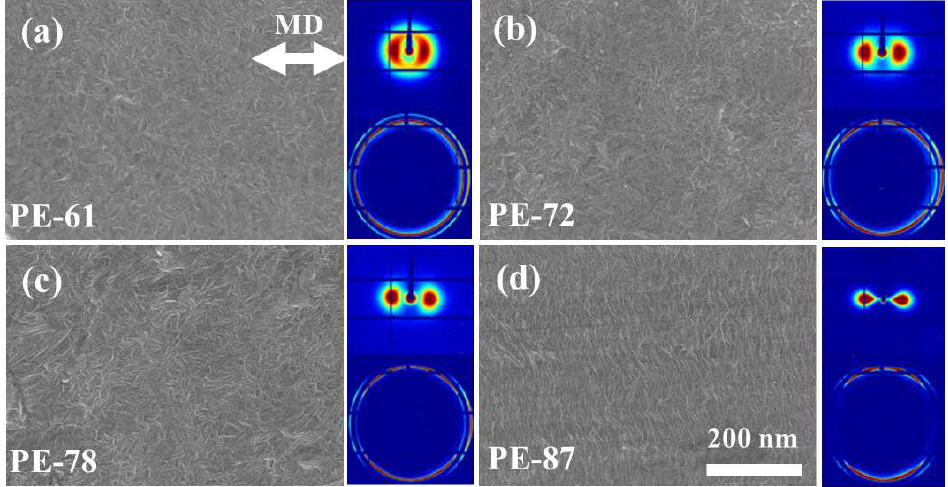
Figure 1. SEM images together with corresponding 2D SAXS and WAXS patterns of mLLDPE precursor films. The scale bar is the same for all